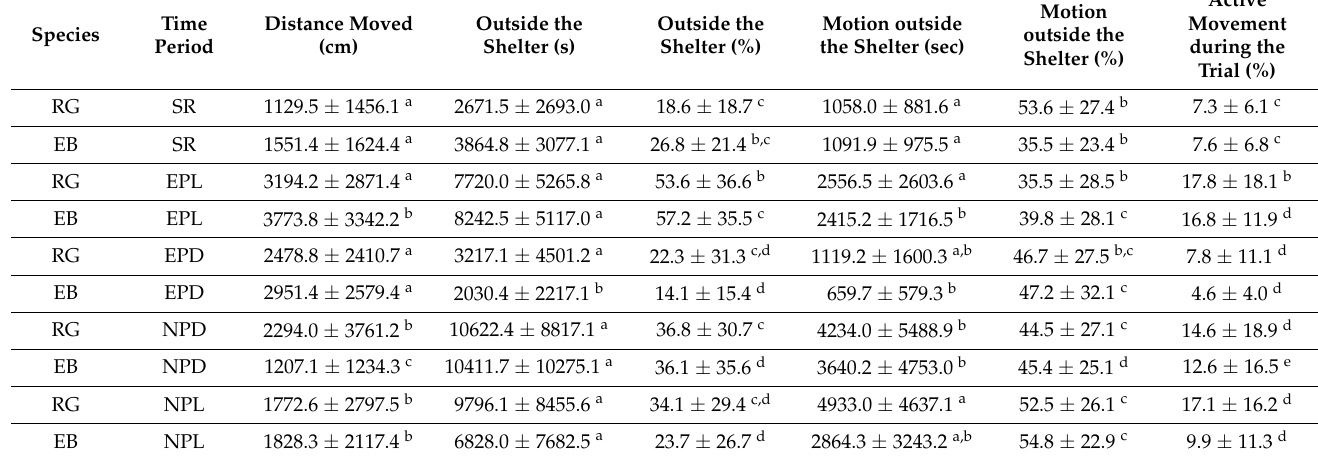
Table 2. The distance moved (cm), time spent outside shelter (sec and %), time spent in motion outside the shelter (sec and %), and proportion of time spent in movement (%) during the trial observed in Neogobius melanostomus (RG) and Cottus gobio (EB). SR = stress response period, EPL = exploration period in light, EPD = exploration period in darkness; NPD = normal behavior period in darkness, NPL = normal behavior period in light. Values with different letters within rows indicate significant intraspecific differences ( α = 0.05). Data are mean ±